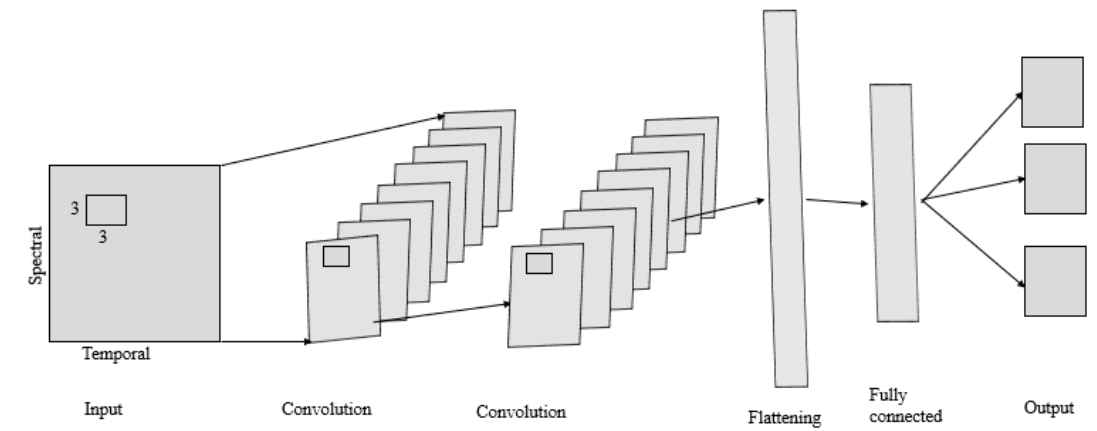
Figure 2. Schematic depiction of the 2D Convolutional Neural Network (CNN) model architecture used.